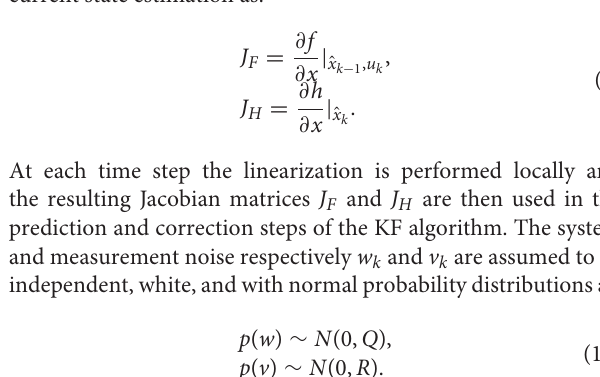
Frontiers in Mechanical Engineering |